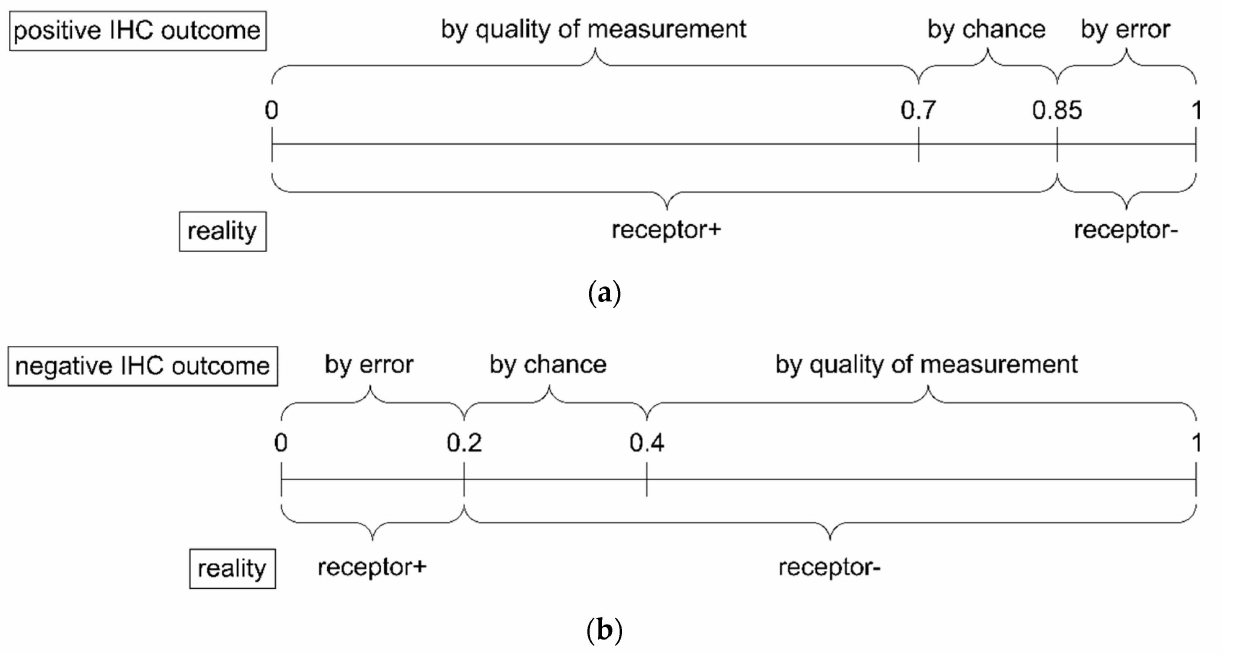
Figure A2. Results of measurements versus reality, seen along the concepts of Dempter–Shafer Theory. In panel ( a ) we focus on positive results only, yielded by IHC measurements (positive results represent 100%), see upper labels. Out of these, 70% are true positives (see lower labels) and result due to quality of the measuring technique. Accordingly, the belief in positive α = 0.7. Another 15% have come out as true positives by chance. The remaining 15% of positive outcomes are due to error, i.e., they are false positives, being truly negative. Both together represent the uncertainty = 0.3) of being receptor positive in reality. In panel ( b ) we focus on negative measurement ( θ IHC + outcomes only: 60% of these come about due to the quality of measurement, 20% were correctly negative by chance and another 20% false negatives, since they are positive in